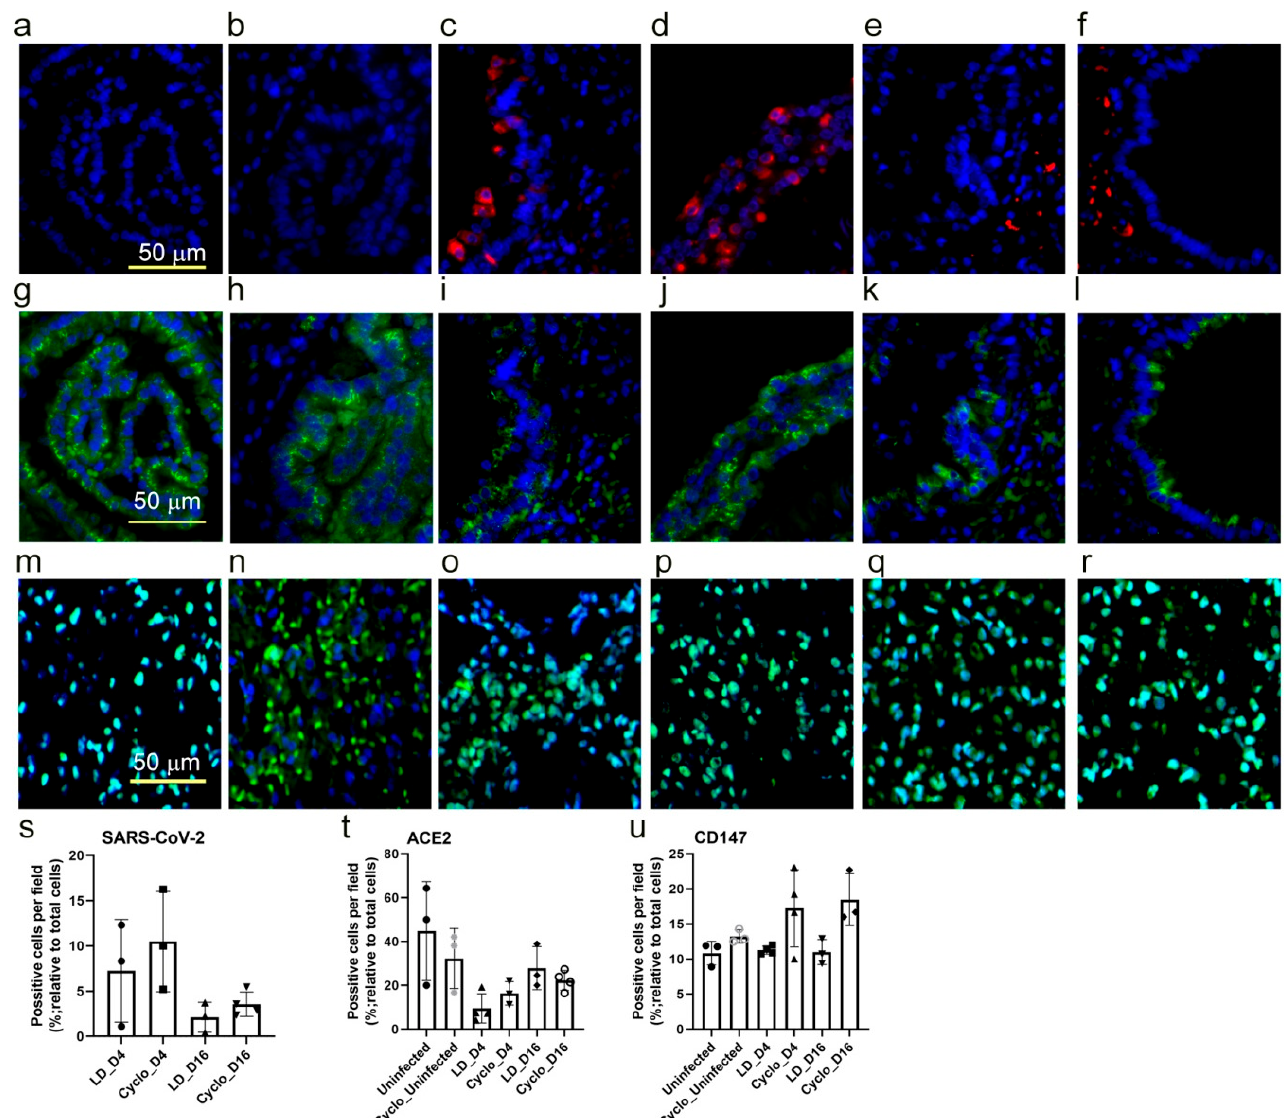
Figure 6. Spatial expression of SARS-CoV-2 host cell entry receptors in immunocompetent and immunocompromised hamsters. Lung sections were stained for SARS-CoV-2 ( a – f ), ACE-2 receptor ( g – l ), or CD147 ( m – r ). Images ( a , g , m ) are uninfected immunocompetent hamster lung sections, and ( b , h , n ) are uninfected immunocompromised hamster lung sections. Images ( c , i , o ) are SARS-CoV-2-infected immunocompetent hamster lung sections at 4 dpi; and ( d , j , p ) are SARS-CoV-2-infected immunocompromised hamster lung sections at 4 dpi. Images ( e , k , q ) are SARS-CoV-2-infected immunocompetent hamster lung sections at 16 dpi; and ( f , l , r ) are SARS-CoV-2-infected immunocompromised hamster lung sections at 16 dpi. The red color in ( c – f ) indicates the presence of SARS-CoV-2, and the green color indicates ACE-2 receptor expression in ( g – l ) or CD147 expression in ( m – r ). Image ( s ) shows lung cells positive for SARS-CoV-2 in immunocompetent (LD) and immunocompromised (Cyclo) hamsters at 4 (D4) and 16 dpi (D16); image ( t ) shows lung cells positive for ACE-2 in uninfected and SARS-CoV-2-infected immunocompetent (LD) and immunocompromised (Cyclophosphamide-treated) hamsters at 4 (D4), and 16 dpi (D16) and ( u ) shows lung cells positive for CD147 in uninfected and SARS-CoV-2-infected immunocompetent (LD) and immunocompromised (Cyclophosphamide-treated) hamsters at 4 (D4) and 16 dpi (D16). n = 3 per group.